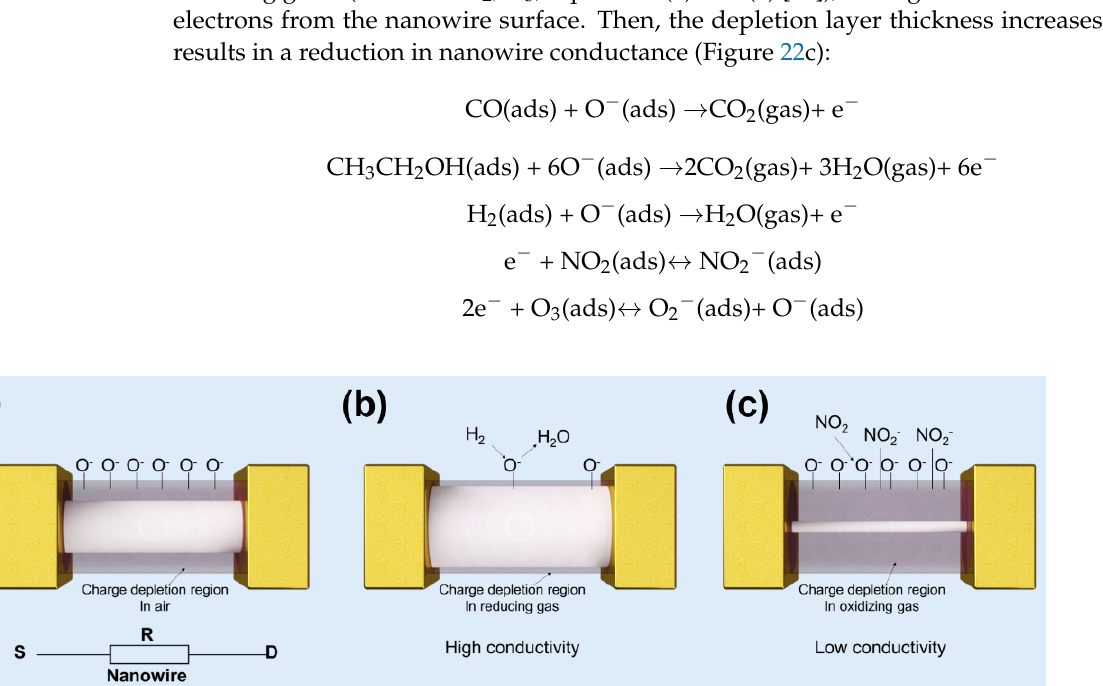
Figure 22. A schematic diagram of conventional chemiresistor sensors: ( a ) nanowire conducting channel exposed to ambient; ( b ) nanowire conducting channel exposed to reducing gases; and ( c ) nanowire conducting channel exposed to oxidizing gases.